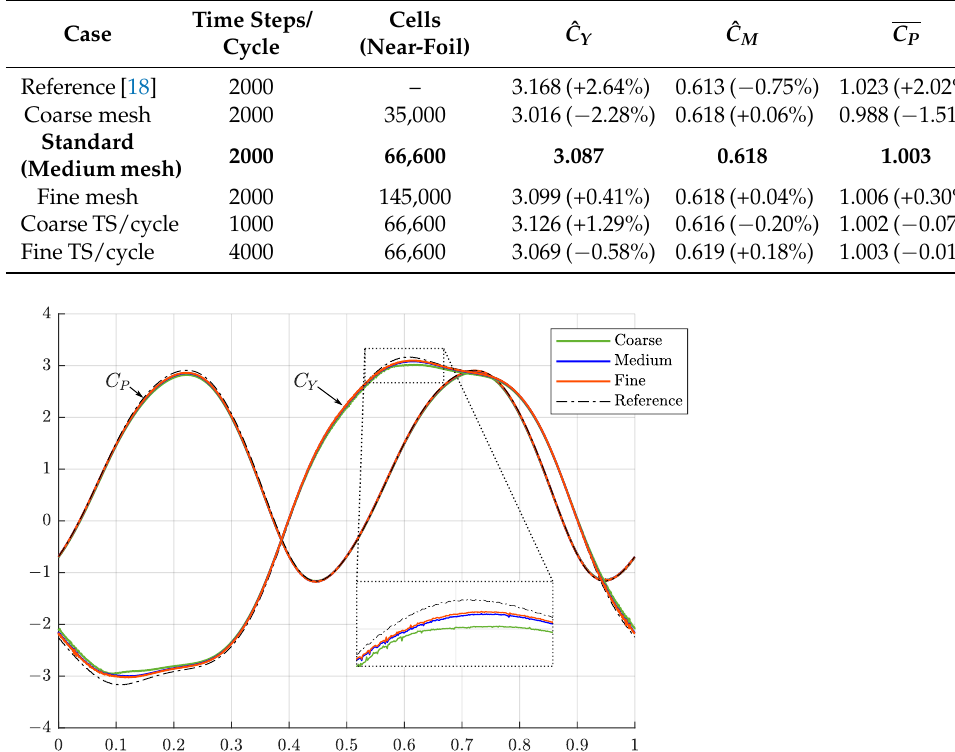
Table 1. Results for numerical parameters sensitivity studies and comparison with Kinsey and Dumas [18]. ( Bold indicates the case with numerical parameters retained for the study).